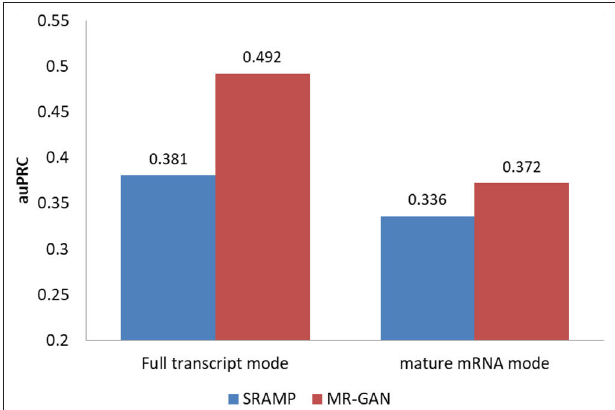
FIGURE 4 | 3D scatterplots of t -SNE projected (A) one-hot encoded samples and (B) MR-GAN features for five epitranscriptome modifications that have a larger number of samples.